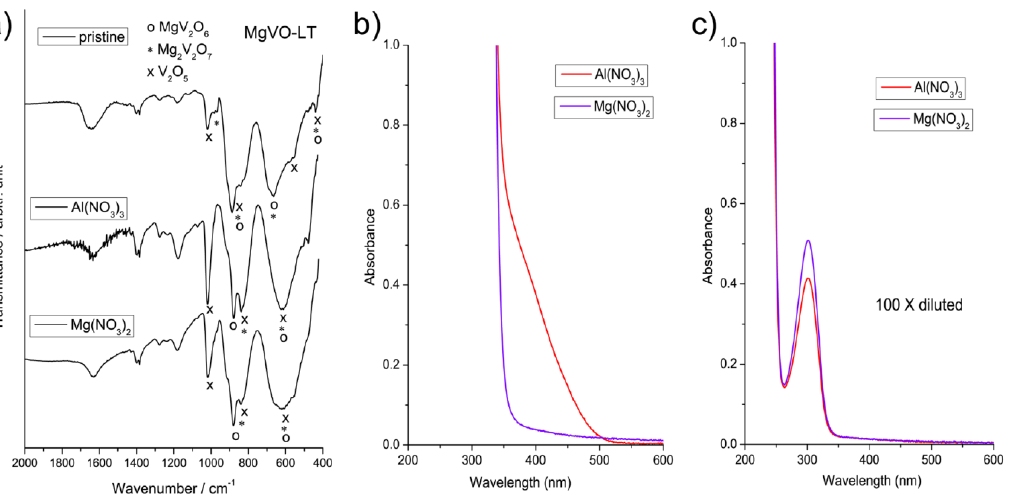
Figure 5. FTIR spectra of the MgVO-LT working electrodes before and after electrochemical measurements in Mg(NO 3 ) 2 and Al(NO 3 ) 3 electrolytes ( a ); UV – Vis absorption spectra of the Mg(NO 3 ) 2 and Al(NO 3 ) 3 electrolytes without dilution ( b ) and 100× diluted ( c ), after electrochemical measurements with MgVO-LT electrodes.